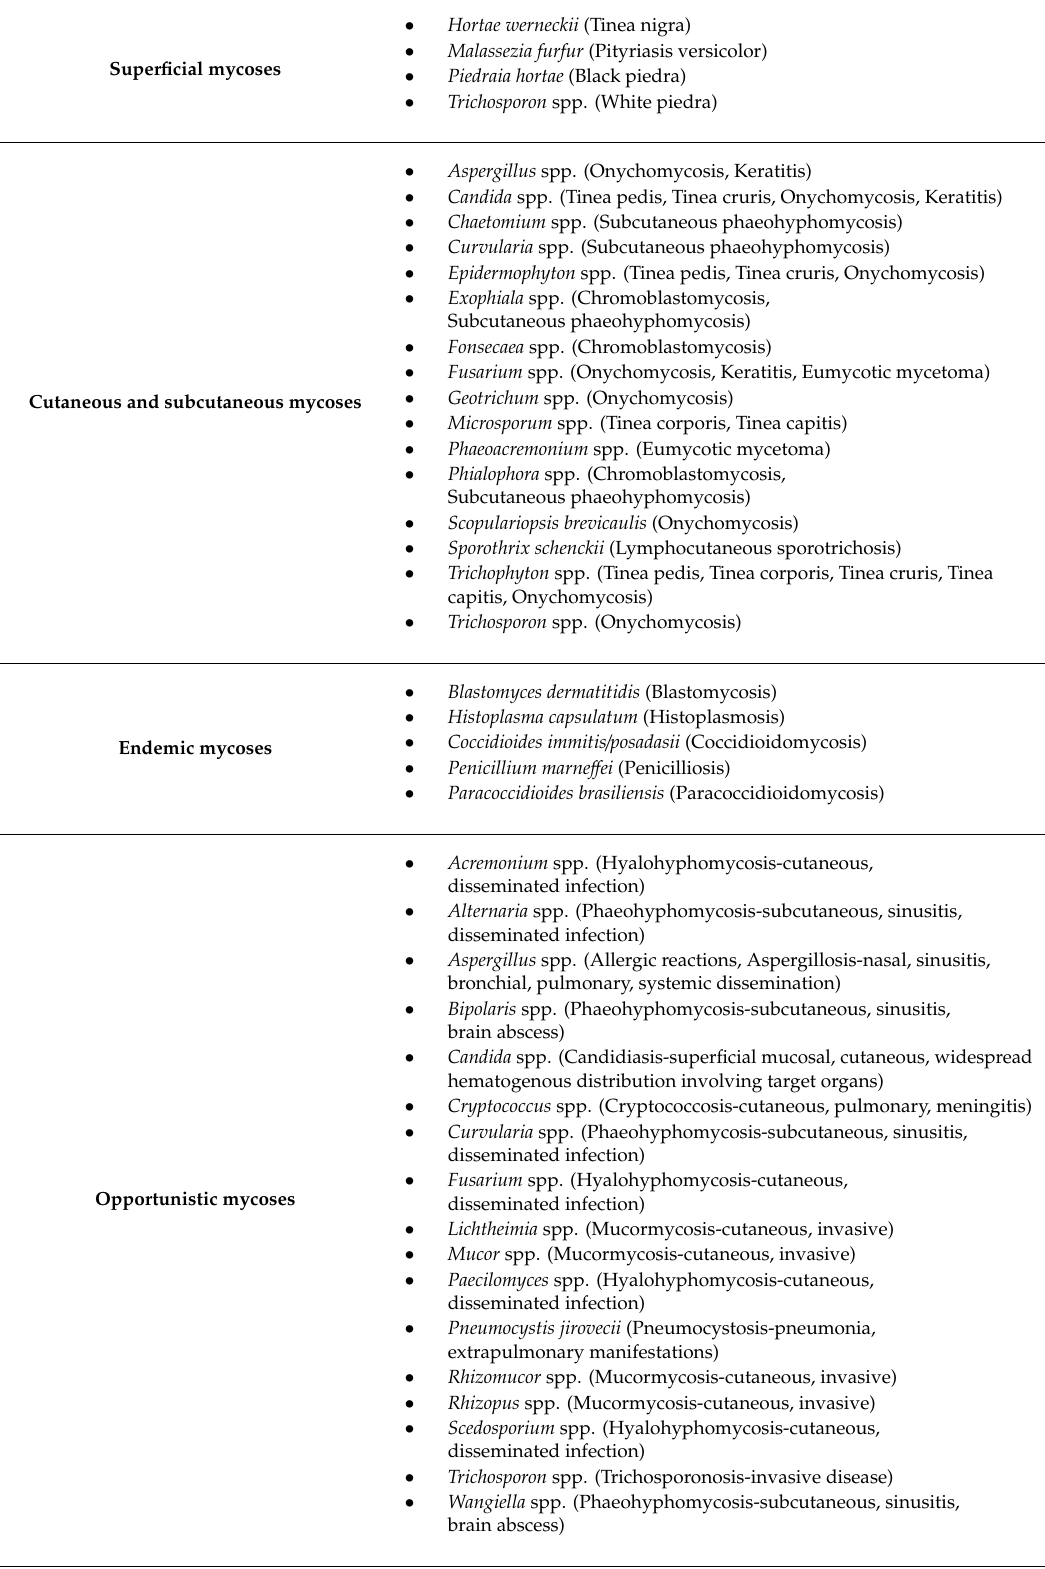
Table 1. Fungal pathogens of humans and most often observed mycoses (based on [6,7]).